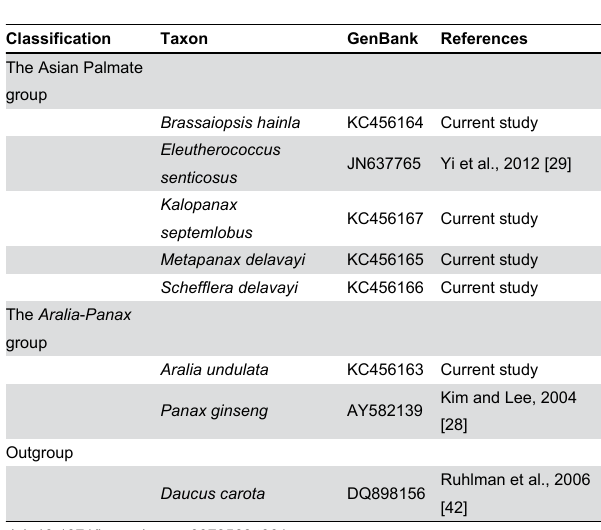
Table 1. Taxa included in phylogenomic analyses of the